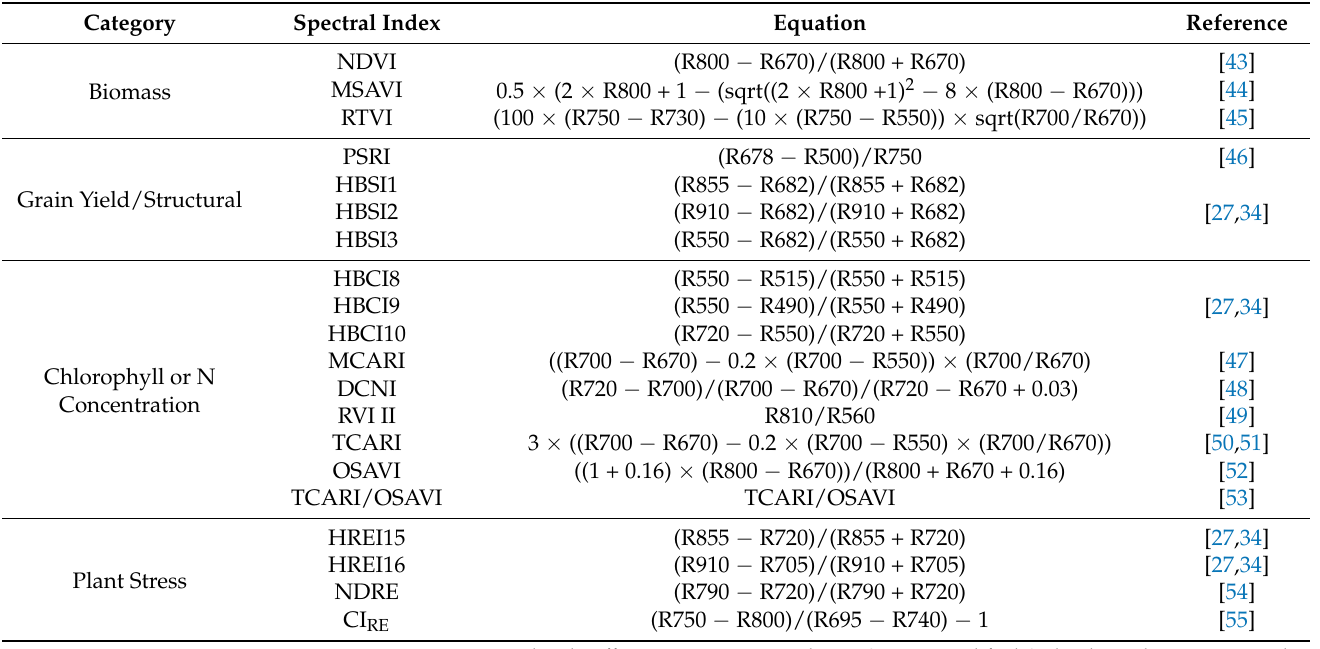
Table 3. Summary of hyperspectral indices (HSI)